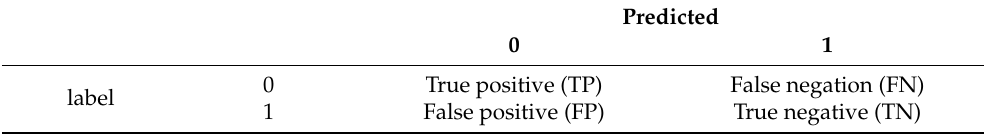
Table 1. The confusion matrix: 0: normal; 1: